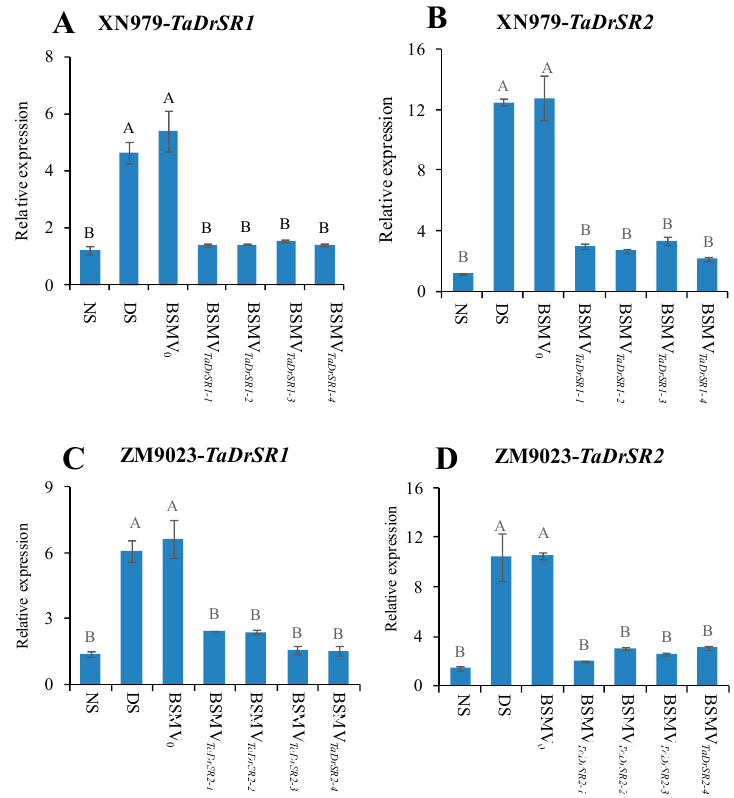
Figure 4. Detection of the expression levels of TaDrSR1 and TaDrSR2 in the corresponding knock-down plants. ( A ) The relative expression levels of the TaDrSR1 gene in the TaDrSR1 -knock-down plants of variety XN979. ( B ) The relative expression levels of the TaDrSR2 gene in the TaDrSR2 -knock-down plants of variety XN979. ( C ) The relative expression levels of the TaDrSR1 gene in the TaDrSR1 -knock-down plants of variety ZM9023. ( D ) The relative expression levels of the TaDrSR2 gene in the TaDrSR2 -knoc- down plants of variety ZM9023; NS, no stress; DS, drought stress. BSMV 0 , negative control of the virus-induced gene silencing (VIGS) system; BSMV TaDrSR1 , TaDrSR1 -knock-down plants; BSMV TaDrSR2 , TaDrSR2 -knock-down plants. Four independent TaDrSR1- and TaDrSR2 -knock-down plants were analyzed, respectively. Different letters indicate significant differences at P ≤ 0.01 levels. In XN979, ten days after infection, slight chlorosis was observed in all the BSMV construct-infected plants; this was attributed to the plant’s response to viral infection. The BSMV PDS -infected plants (positive control) exhibited bleached leaves (Figure 5A), indicating that the infection was successful [44]. Twenty days after infection, a substantial level of leaf drooping and wilting was observed in both BSMV TaDrSR1 - and BSMV TaDrSR2 -infected plants. However, no significant sagging and withering of